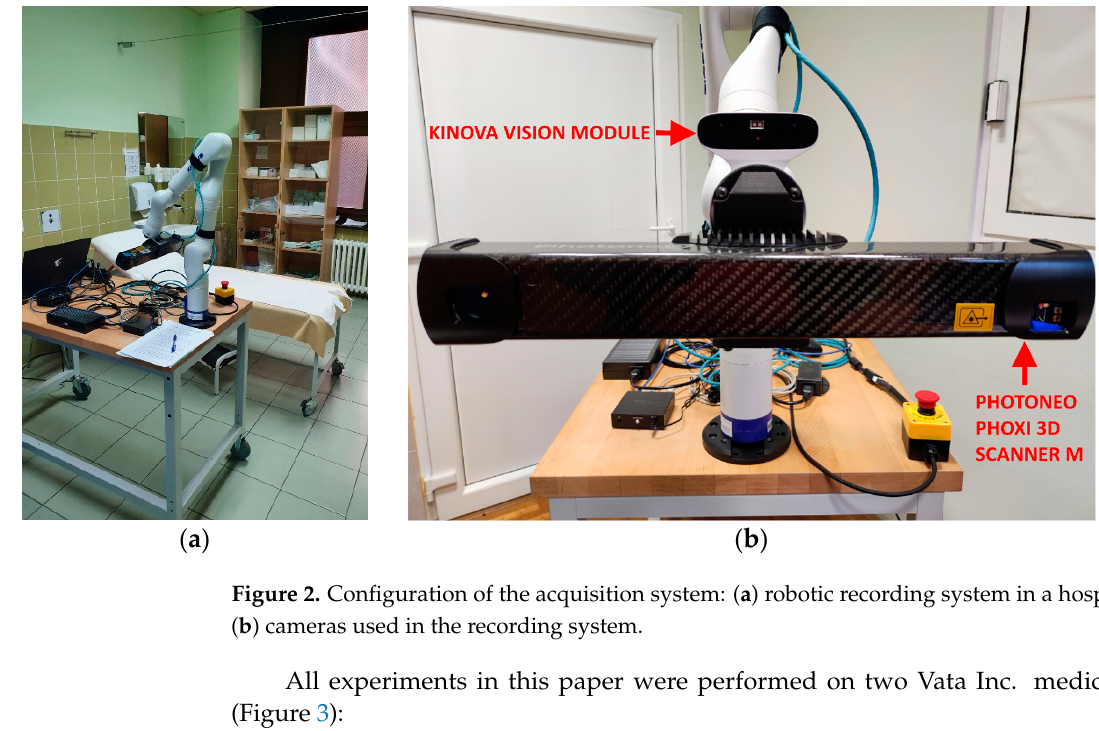
Figure 2. Con fi guration of the acquisition system: ( a ) robotic recording system in a hospital se tt ing; ( b ) cameras used in the recording system.